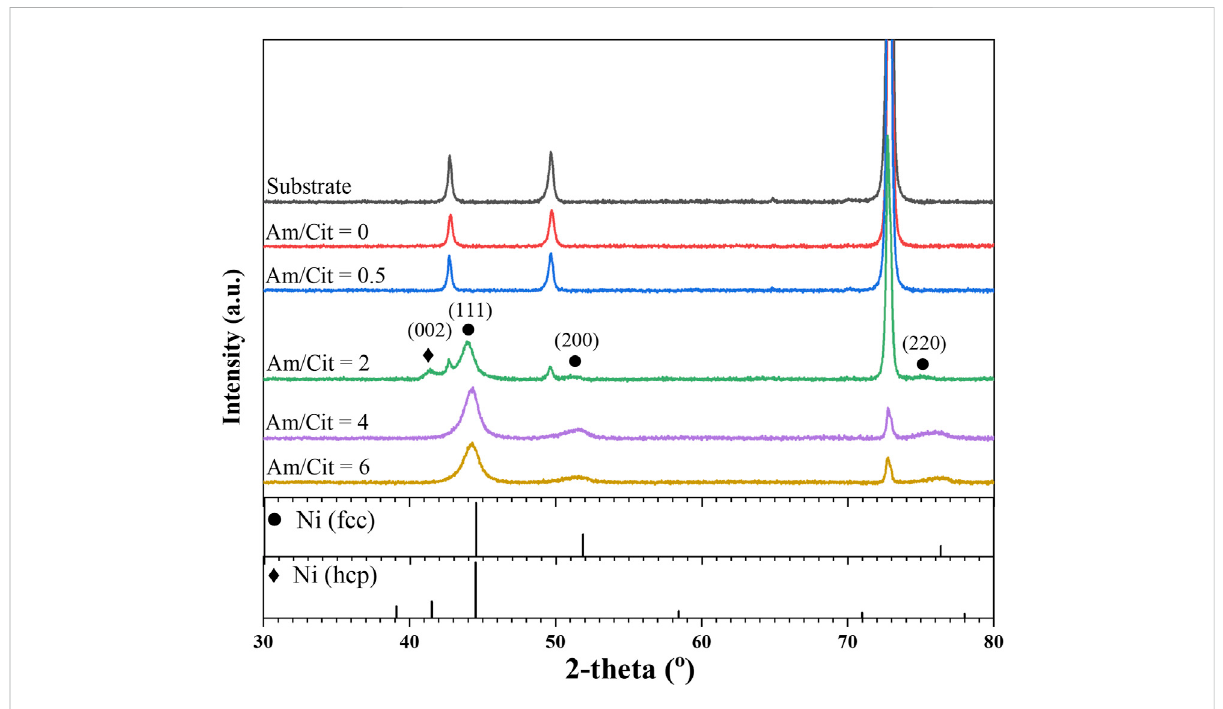
FIGURE 8 XRD spectra of deposits as a function of NH 4 + concentration at fi xed 0.1 M Ni 2+ , 0.05 M MoO 4 2- , 0.05 M citrate, and 0.2 M NH 4 +